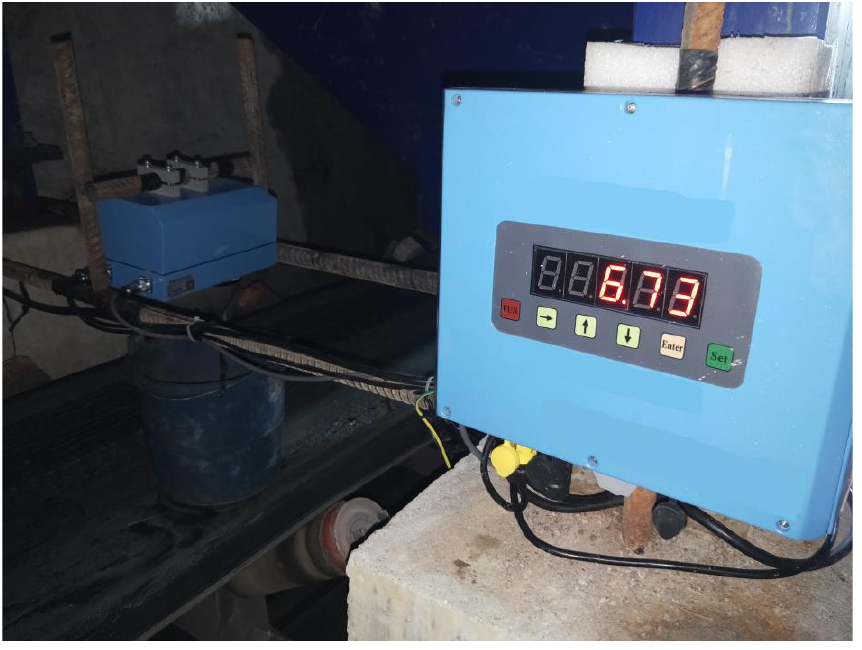
Figure 9. Testing of aggregate moisture using rapid monitoring technology.